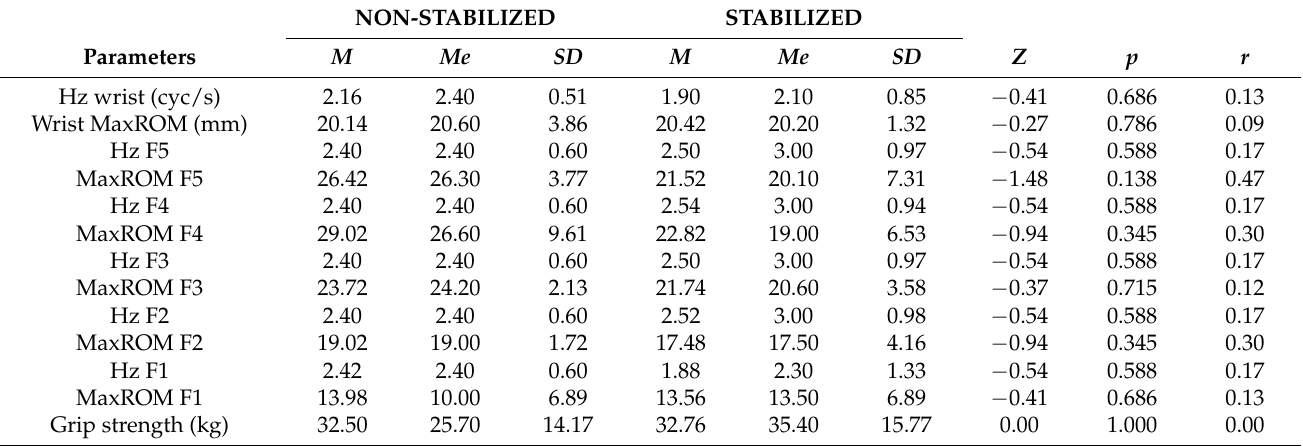
Table 4. Comparison of the results of parameters in the non-stabilized and stabilized position for the 18–45-year-old age group of people after